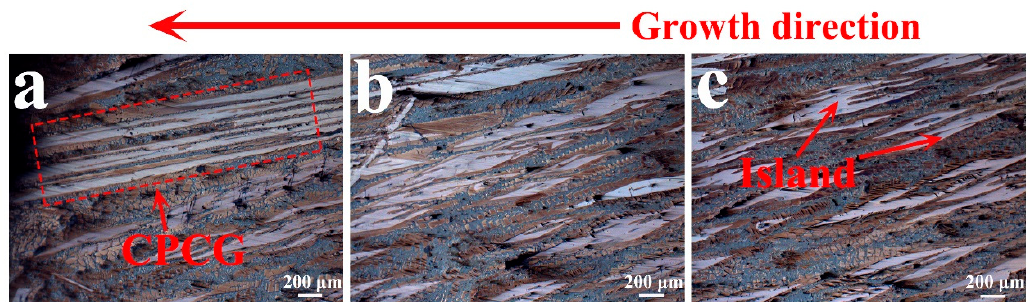
Figure 2. The Optical microscope (OM) image of the longitudinal section of the CuCe alloy at a withdrawal rate of 10 µ m / s. ( a ) Cellular peritectic coupled growth (CPCG); ( b ) Closed island structure, and ( c ) Island structure.